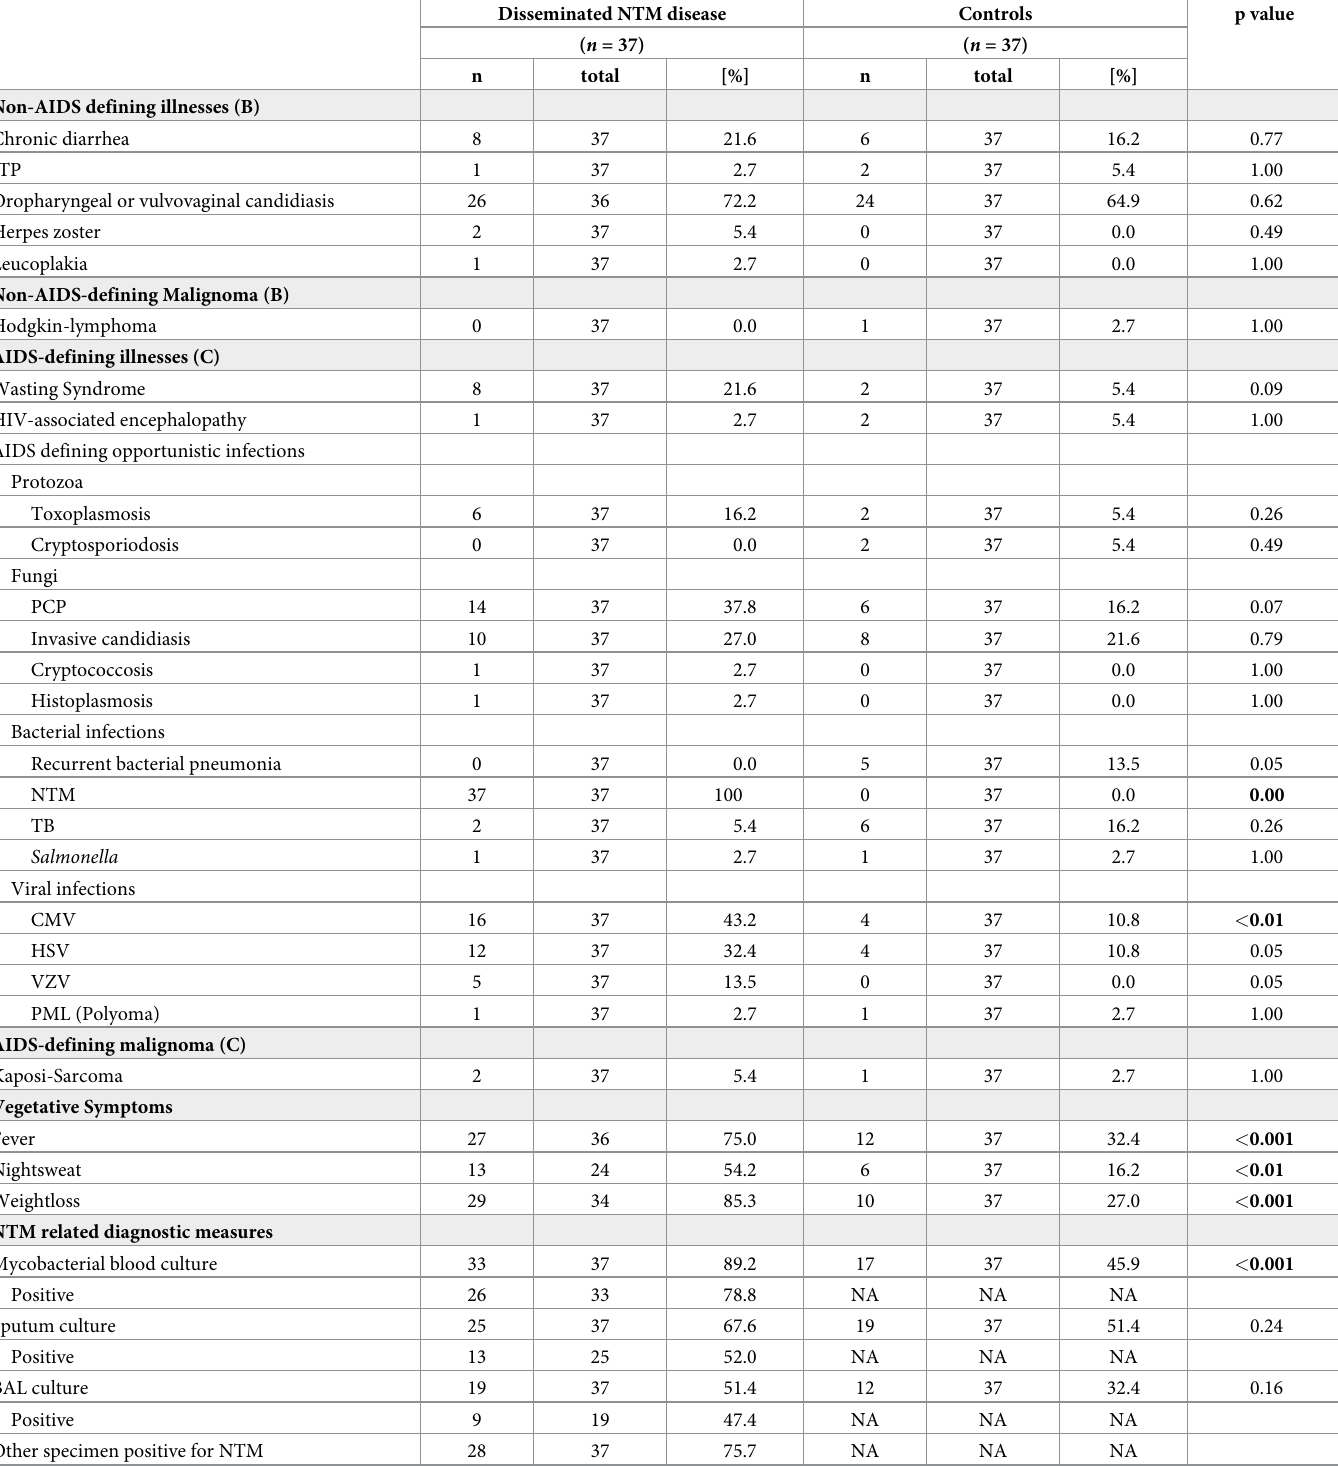
Table 2. Opportunistic infections, AIDS related malignancies, vegetative symptoms, NTM related diagnostics and complications in patients with disseminated NTM disease and controls. Opportunistic infections or comorbidities that did neither occur in the case nor in the control group are not